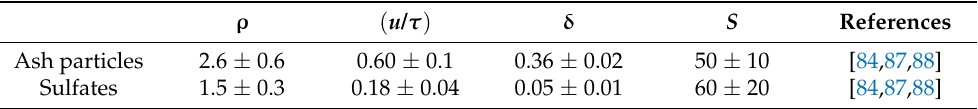
Table 2. Input parameters for the separation of ash and sulfates contribution to β 532 and mass concentration